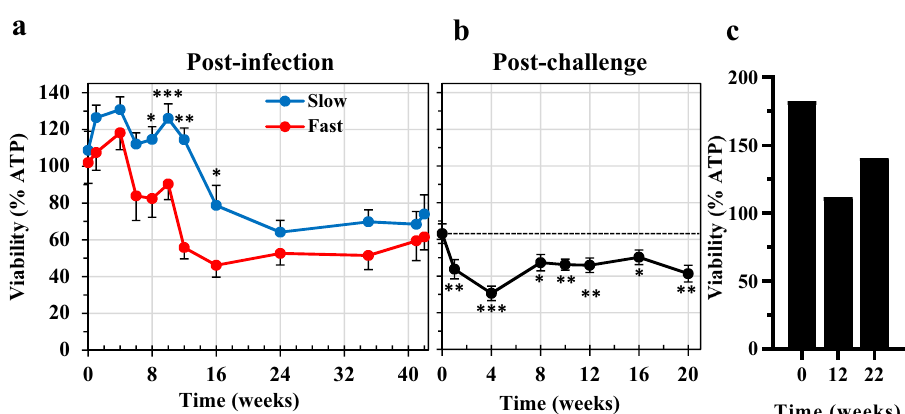
Fig. 7 Enhanced mortality of 3-day-old schistosomula cocultured with rhesus plasma. a The viability of 3-day-old schistosomula cultured for a further 48 h in the presence or absence of 33% v/v plasma, from Fast or Slow group animals, collected at the time points indicated over the post-infection period. Viability is expressed as % luminescence values of the test cultures, relative to the cultures without plasma. Values plotted are the means ± SE, n = 4 macaques from the Slow and 4 from the Fast groups; three biological replicates were assayed. Statistical comparisons between Fast and Slow groups made at each time point using one-sided Student ’ s t -test; signi fi cance indicated by P < 0.05 *, <0.01**, <0.001***. b The viability of 3-day-old schistosomula cultured for a further 48 h in the presence or absence of 33% v/v plasma collected at the time points indicated over the post-challenge period. Values plotted are the means ± SE; n = 11 rhesus macaques, excluding Rh10; three biological replicates were assayed. Statistical comparisons of % viability were made relative to the value at the Week 42 day of the challenge, using one-sided Student ’ s t -test with signi fi cances P < 0.05 *, <0.01**, <0.001***. c Control assay, showing the viability of 3-day-old schistosomula cultured for a further 48 h in the presence, relative to the absence of 33% v/v serum collected from permissive hamster animals infected with S. mansoni . Serum collected at time zero, and at 12- and 22-weeks post-infection; two biological replicates were assayed. Source data are provided as a Source Data fi